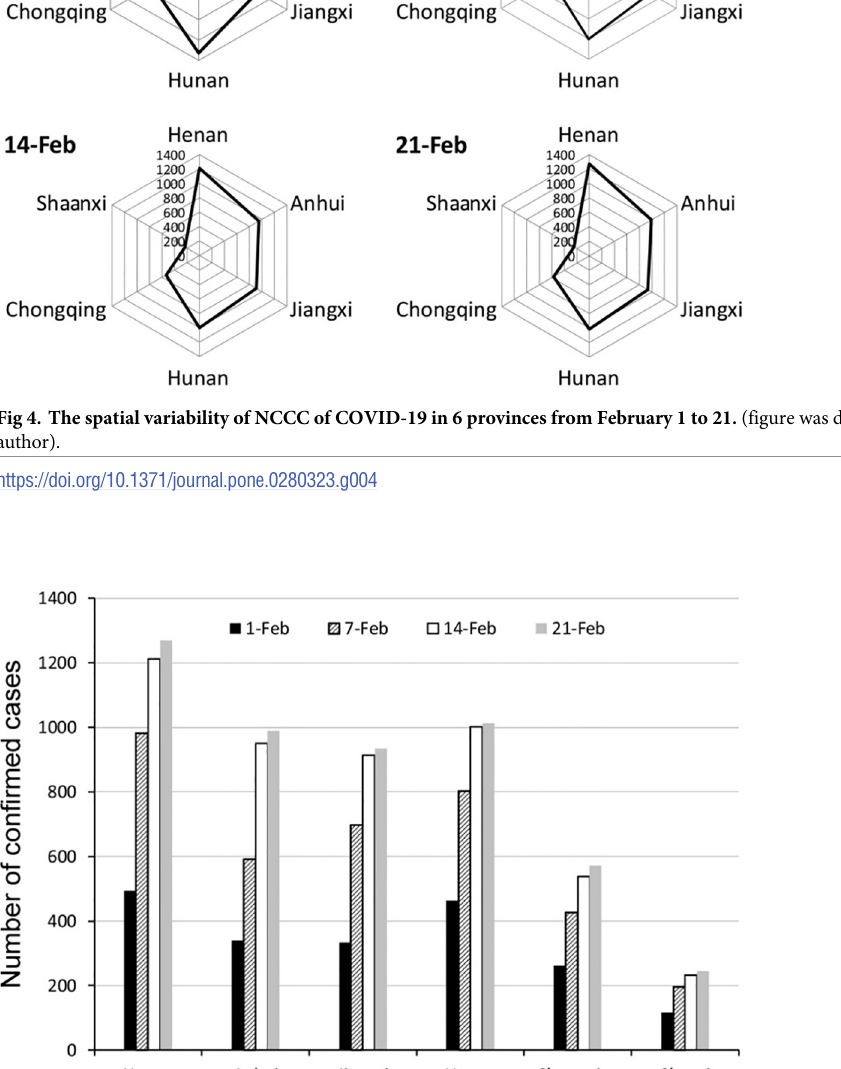
PLOS ONE | https://doi.org/10.1371/journal.pone.0280323 January 20,